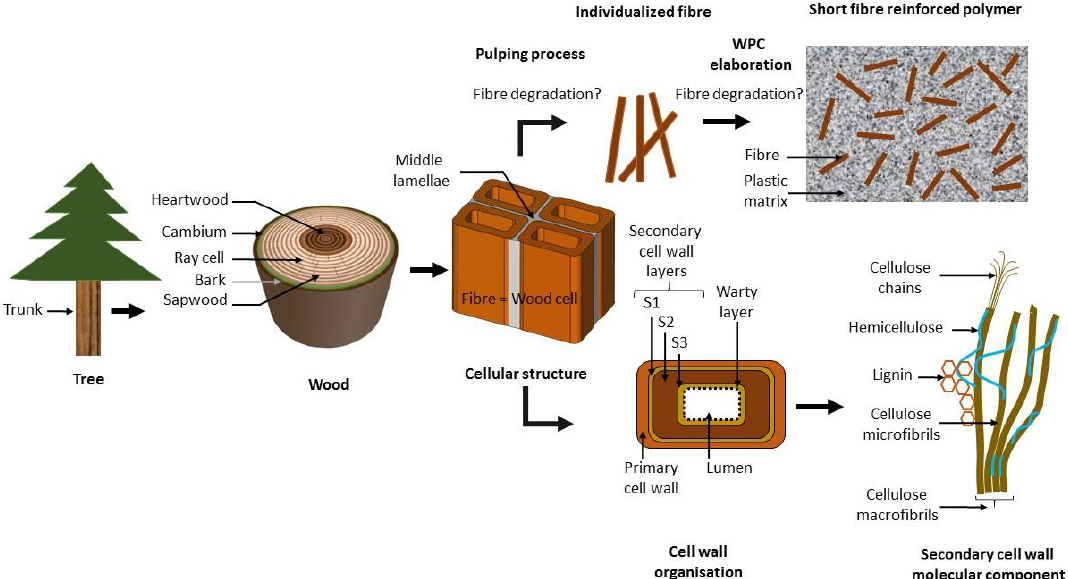
Figure 1. Overview of wood; from a living tree to the molecular organisation and its